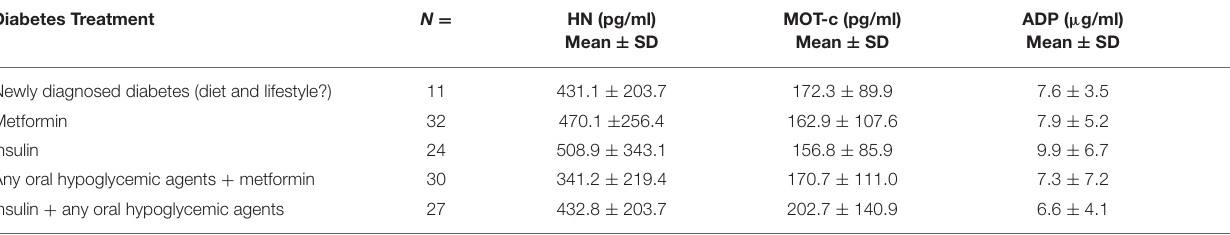
TABLE 3 | Effects of antidiabetic medications on serum HN, MOTS-c and ADP levels. Diabetes Treatment N =